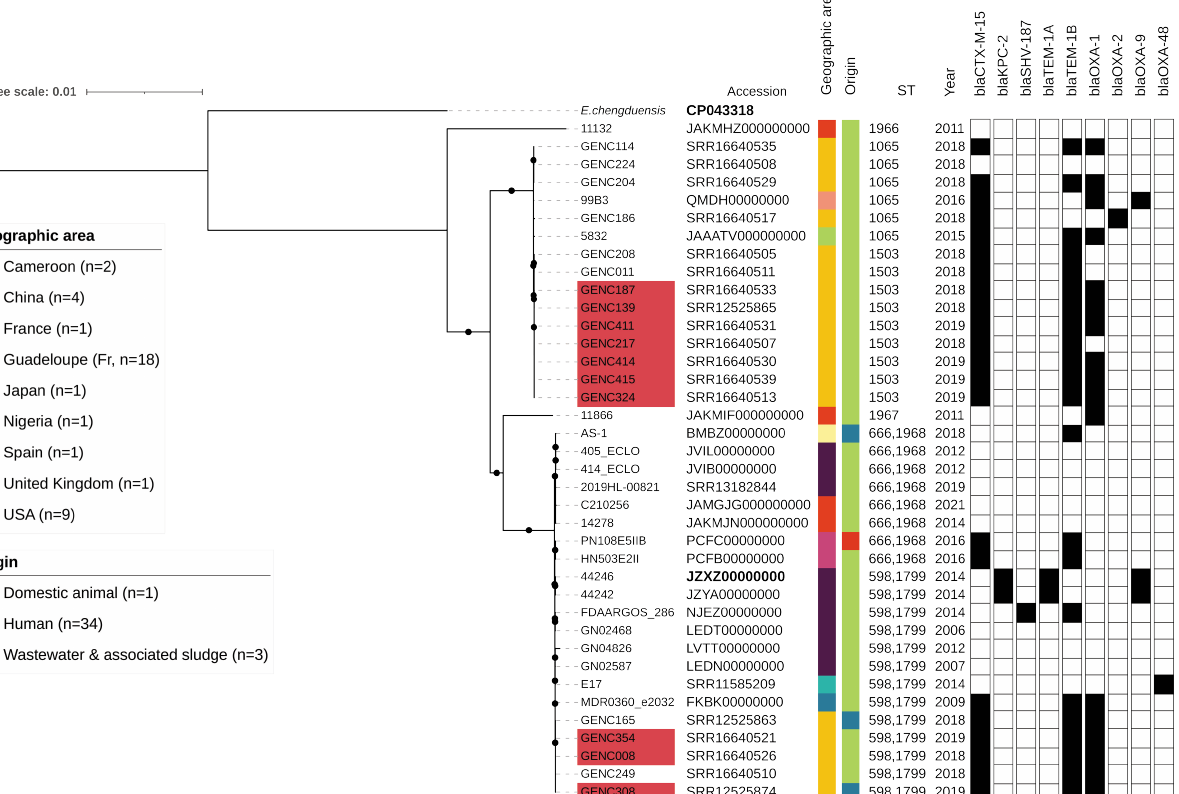
Figure 4. Maximum likelihood phylogenetic tree of E. cloacae complex (ECC) taxon 4 isolated in Guadeloupe ( n = 18) and internationally ( n = 20). The core-genome phylogenetic tree was drawn with iTOL, from 38 genomes recovered worldwide between 2006 and 2021 [24]. The tree was rooted with E. chengduensis reference (in bold: CP043318) [5,26]. ECC taxon 4 reference is also presented in bold (JZXZ00000000) [5], and only bootstrap values equal to 100% are indicated by a black circle. The following metadata are indicated: date of isolation, sequence type (ST) and antibiotic resistance genes in black squares. Only acquired genes that confer resistance to β -lactam antibiotics were included. Strains with a bla CTX-M-15 gene with a location predicted on a plasmid and an IncHI2/ST1 plasmid replicon are shown in red. Metadata are shown in Supplementary Data Set